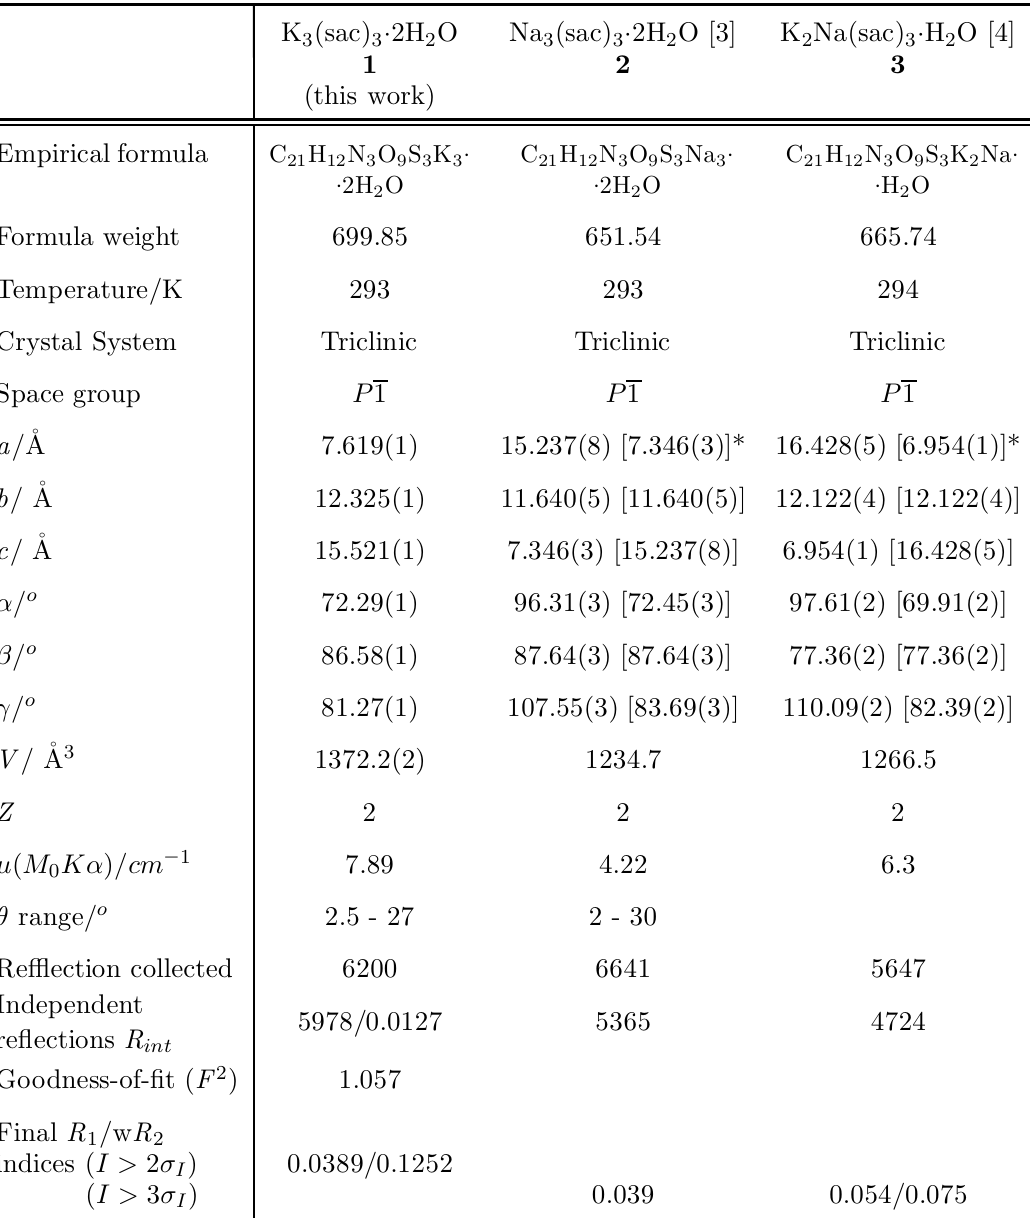
Table 1 Crystal data and structure re› nement for K 3 (sac) 3 ¢ 2H 2 O, and the respective data